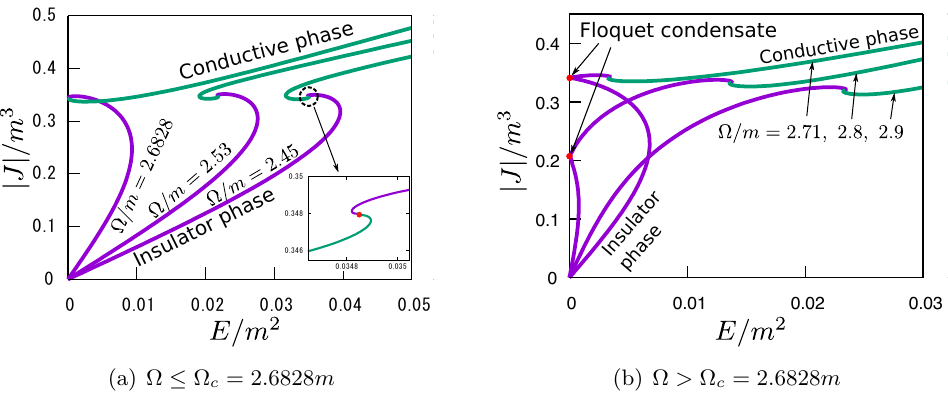
Figure 8 . Absolute values of magnitude of the rotating electric currents as functions of the electric (cid:12)eld for (cid:12)xed several (cid:10). The left (right) panel shows data for frequencies below (above) the critical frequency. The purple and green curves are for insulator and conductive phases, respectively. The inset of the left panel shows the spiral structure at the phase